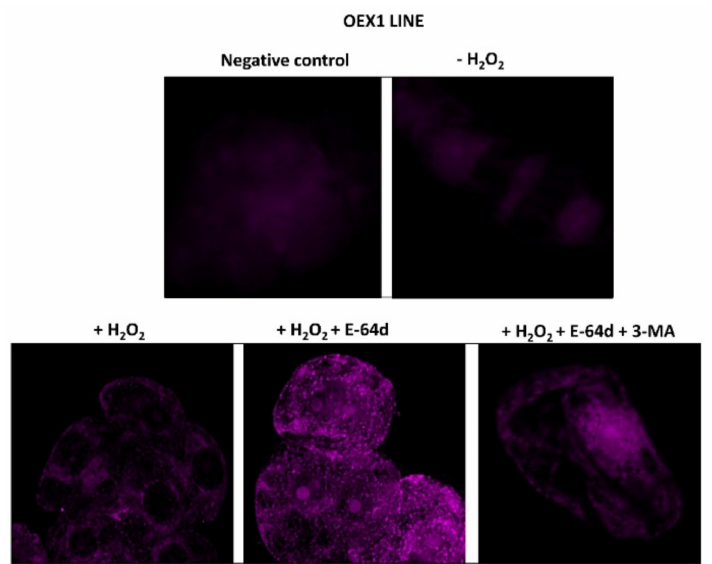
Figure 6. Immunodetection of ATG8 in overexpressing Pstrxo1 OEX1 tobacco BY-2 cells treated with 35 mM H 2 O 2 . Five-day-old overexpressing (OEX1) Pstrxo1 TBY-2 cells were treated in the absence (-) and presence (+) 35 mM H 2 O 2 alone or in combination with E-64d and 3-MA and collected and processed after 24 h for immunofluorescence microscopy, as described in Material and Methods. Fluorescence images of the signal recognized by the anti-CrATG8 antibody (purple punctates) are shown as representative of three independent experiments after using the Huygens Essential Microscopy Analysis software. A negative control without incubation with the primary antibody is also